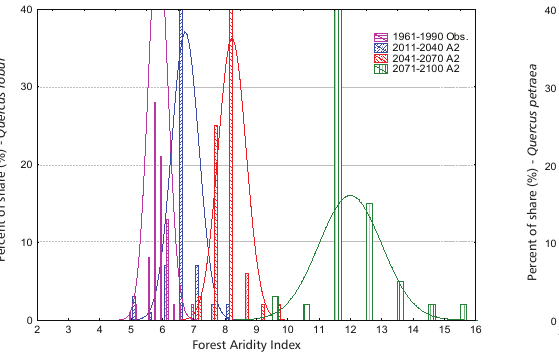
FIGURE 2. Distribution of Pedunculate oak across FAI categories in four climate periods